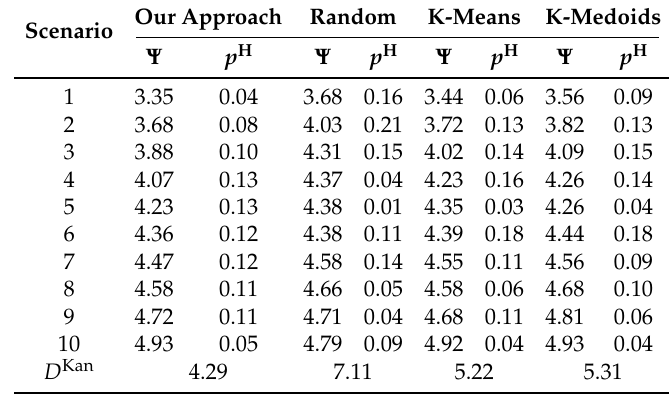
Table 4. Social welfare ( Ψ , in $10 15 ) and probability ( p H ) of 10 selected scenarios and the Kantorovich distance ( D Kan in $10 19 ) for Transmission Plan 1. The 10 selected scenarios for different approaches may be different.